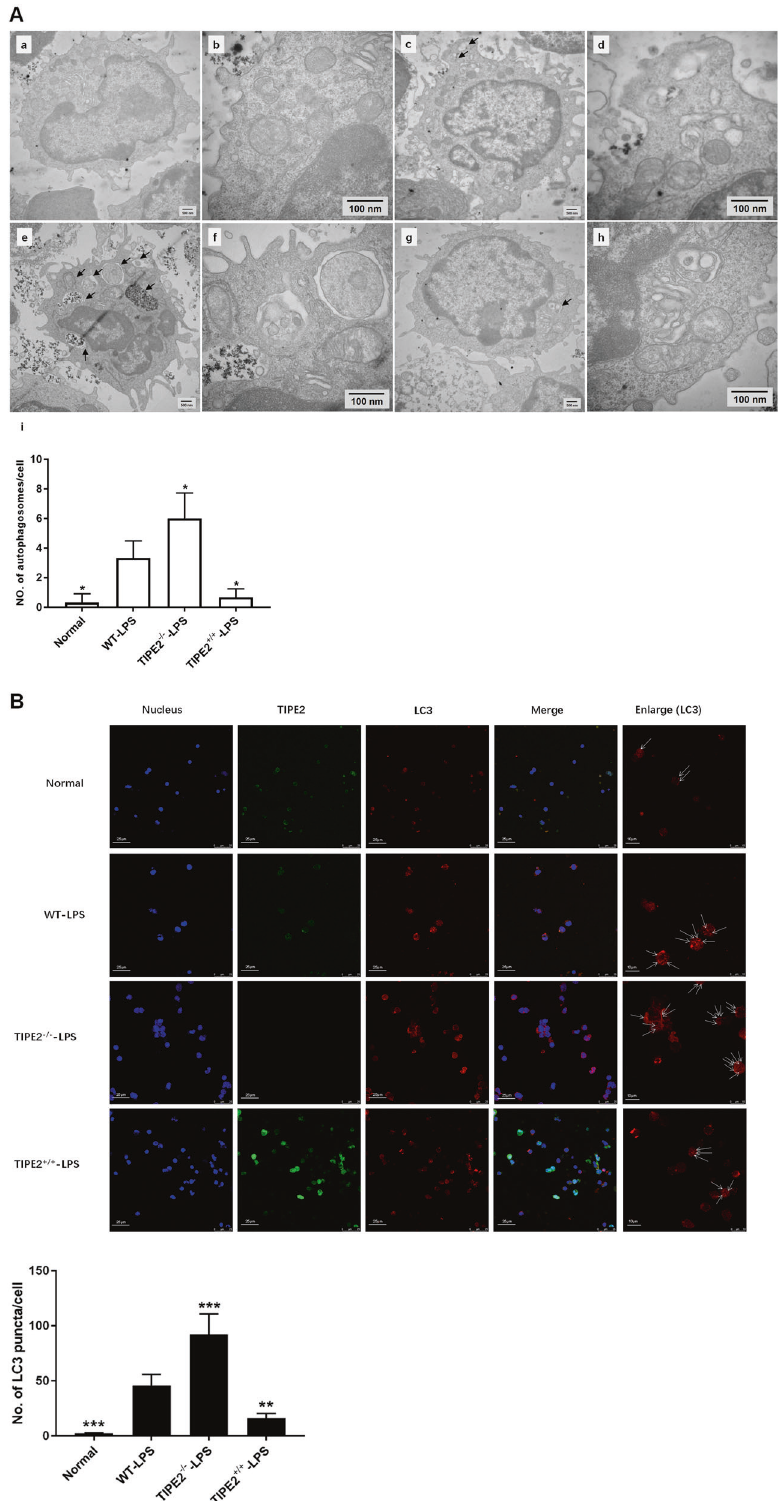
Fig. 2 Inhibitory effect of TIPE2 on the formation of autophagosomes in DCs in vitro. A Transmission electron microscope was used to assess the autophagosomes in DCs in the four groups (a, b: the normal group; c, d: the WT-LPS group; e, f: the TIPE2 − / − -LPS group; g, h: the TIPE2 + / + -LPS group; i: histogram of the number of autophagosomes per cell; a, c, e, g, scale bar = 500 nm; b, d, f, h, scale bar = 100 nm), arrows indicated autophagosomes which are de fi ned as a double-membraned structure containing the rem-nants of cellular organelles. B Laser- scanning confocal microscopy was used to observe the puncta of LC3. It is shown by anti-TIPE2 antibodies (green) and LC3 (red) using immuno fl uorescence and confocal microscopy (×600, scale bar = 25 μ m; ×1200, scale bar = 10 μ m). In addition, the cell nuclei were stained blue by dihydrochloride (DAPI). Data of three independent experiments are represented as mean ± SD ( n = 6 in each group). Statistical signi fi cances: compared with the WT-LPS group, * P < 0.05, ** P < 0.01, *** P < 0.001. Cell Death and Disease (2021)